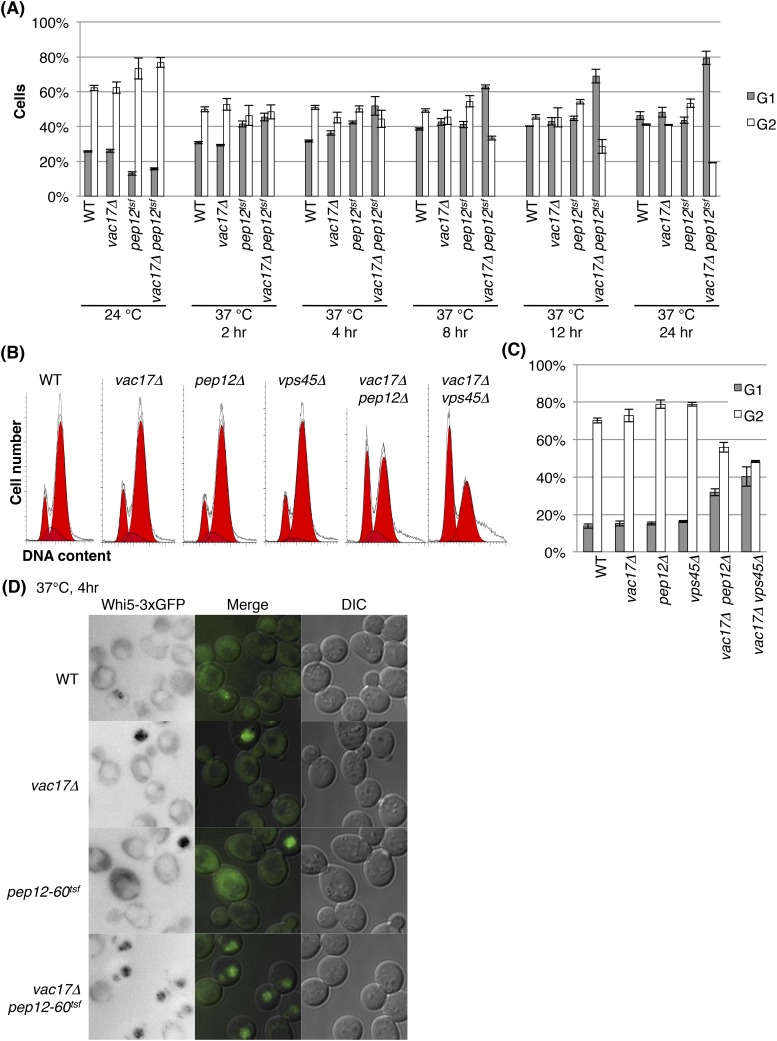
The vacuole is required for cell-cycle progression from early G1 phase.(A) The vac17Δ pep12-60tsf double mutant is arrested in G1 phase at the restrictive temperature, 37°C. Percent cells in G1 (1N DNA) and G2 (2N DNA) phase after incubation at 37°C for 0, 2, 4, 8, 12, or 24 hr. Percent cells arrested in G1 are also shown in Figure 3B. Error bars; SD calculated from four independent experiments. (B) vac17Δ pep12Δ and vac17Δ vps45Δ double mutants exhibit an accumulation of cells arrested in G1 phase. Flow cytometry analysis of PI staining of yeast strains; wild-type, vac17Δ, pep12Δ, vps45Δ, vac17Δ pep12Δ, and vac17Δ vps45Δ. (C) Quantification of percent cells in G1 and G2 phase. Error bars; SD calculated from four independent experiments. (D) The vac17Δ pep12-60tsf double mutant arrests in early G1 phase at the restrictive temperature, 37°C. Wild-type, vac17Δ, pep12-60tsf, and vac17Δ pep12-60tsf cells which express Whi5-3xGFP from its endogenous locus, were incubated at 24°C overnight, and then sifted to 37°C for 0 or 4 hr. Images of Whi5-3xGFP localization after cells were incubated at 37°C for 4 hr. Quantification is shown in Figure 3C.